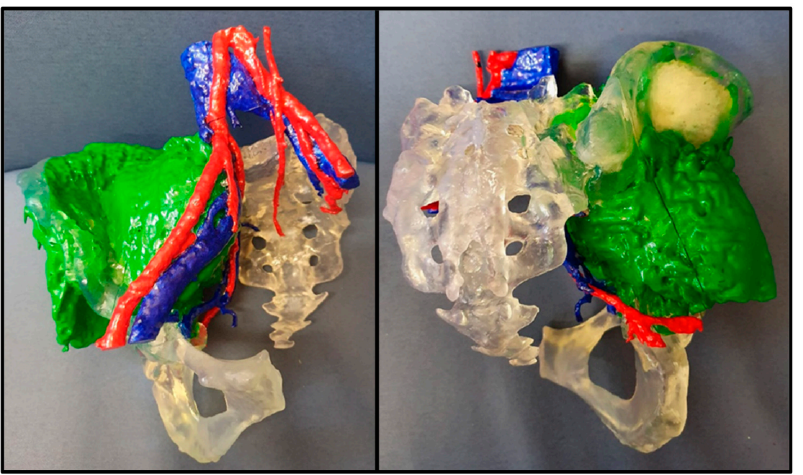
Figure 7. Images show a 3D printed model of a pelvic tumour with a large soft tissue component, demonstrating both the extent of the tumour, and its relationship to the blood vessels (model from